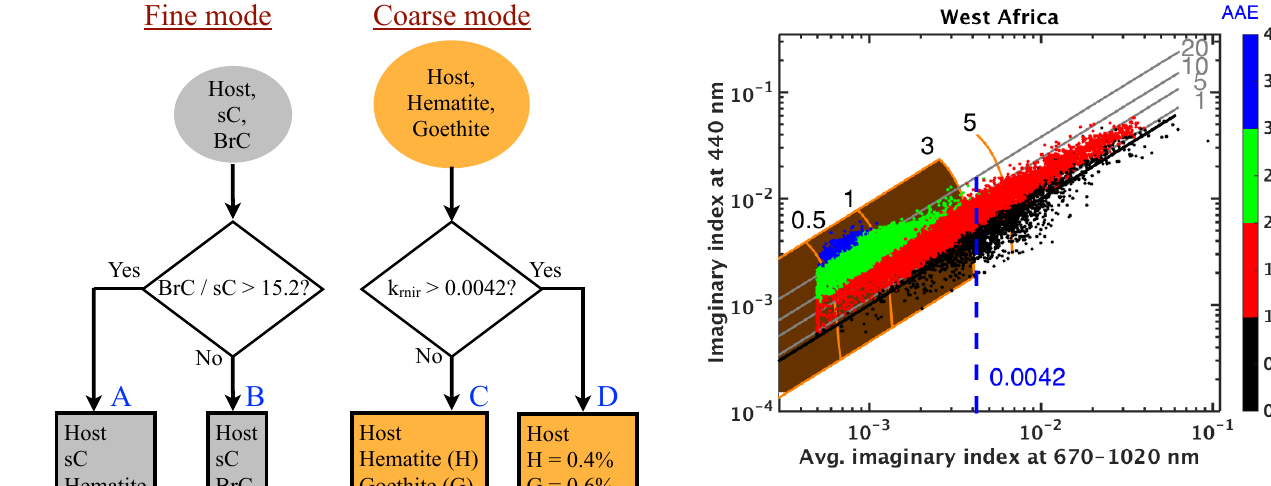
Figure 7. All level 2.0 retrievals for the West African AERONET sites of Table 2, including mixtures of biomass burning and dust. Many of the points are located above the uppermost grey line, which would require BrC / sC ratios greater than 15.2 for a mixture con- taining only carbonaceous aerosols. Likewise, retrievals to the right of the shaded area require iron oxide volume mixing ratios greater than 3% if no carbonaceous aerosol is